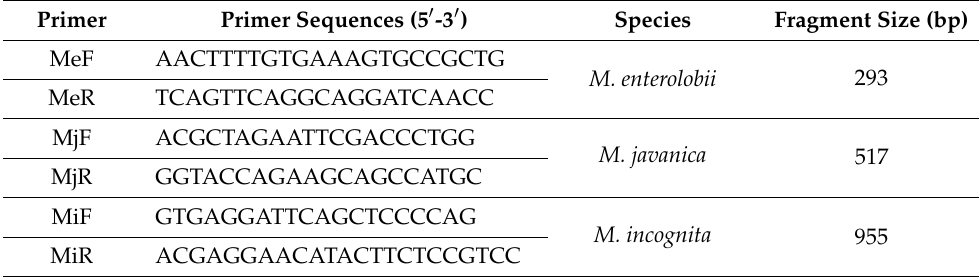
Table 1. Primers used for molecular identification of root-knot nematodes.